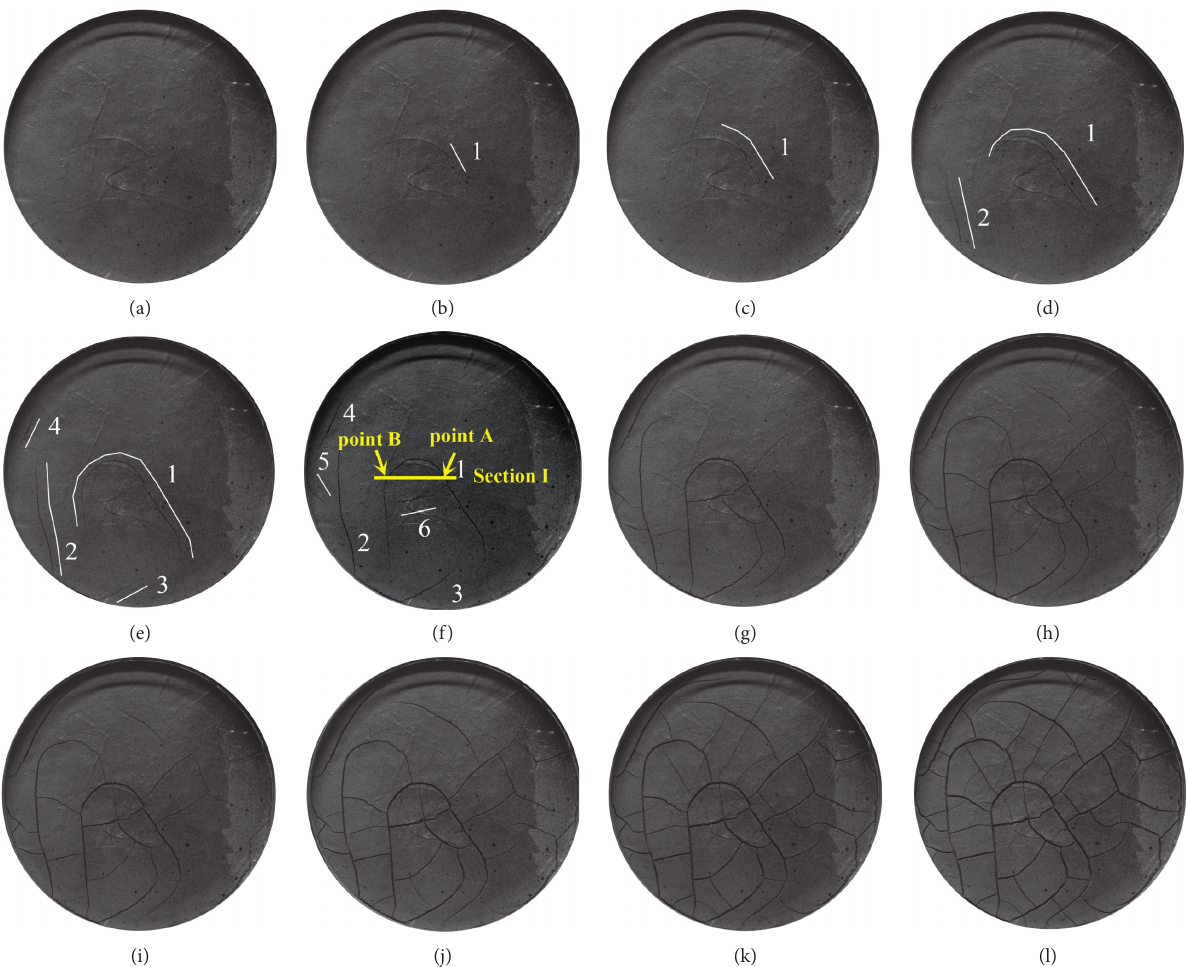
Figure 11: Evolution of cracks at different times. (a) t � 0h. (b) t � 15.3 h. (c) t � 16.3h. (d) t � 17.8 h. (e) t � 18.8h. (f) t � 19.5 h. (g) t � 20.5h.